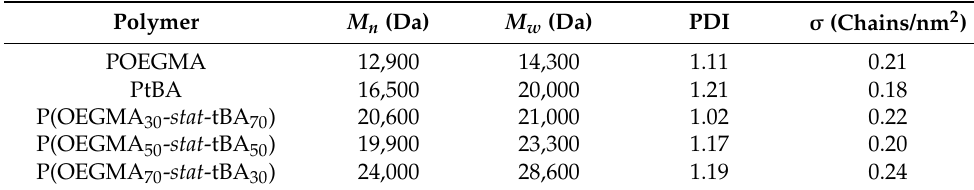
Figure 4. Thermogravimetric analysis (TGA) curves of SiO 2 , SiO 2 -NH 2 , SiO 2 -Br, SiO 2 - g -PtBA, SiO 2 - g -POEGMA, SiO 2 - g -P(OEGMA 30 - stat -tBA 70 ), SiO 2 - g -P(OEGMA 50 - stat -tBA 50 ), and SiO 2 - g - P(OEGMA 70 - stat -tBA 30 ). Table 2. Molecular weight and the polydispersity index of POEGMA, PtBA, P(OEGMA 30 - stat -tBA 70 ), P(OEGMA 50 - stat -tBA 50 ) and P(OEGMA 70 - stat -tBA 30 )